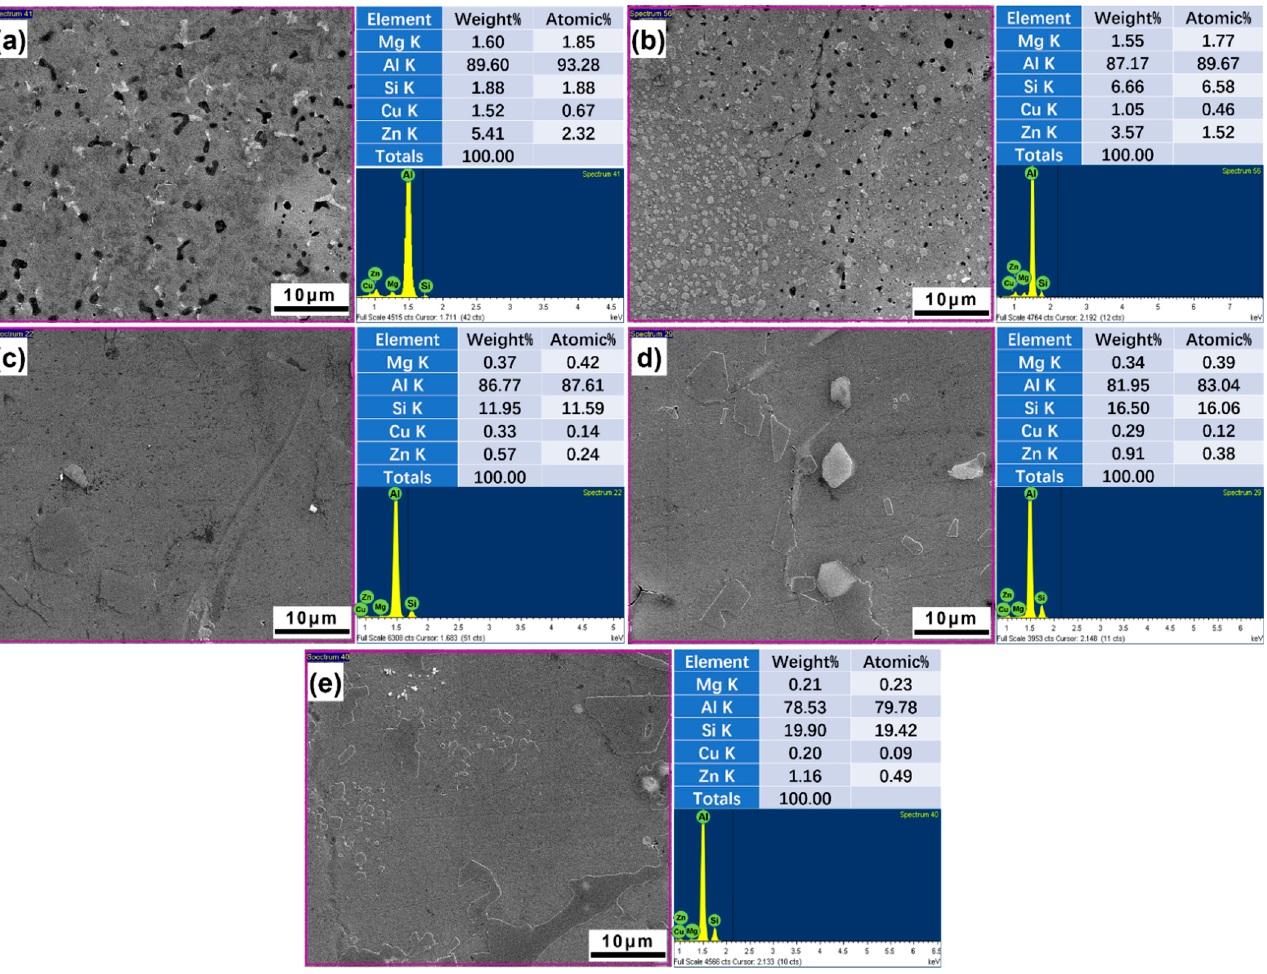
Figure 3. Microstructures and EDS results of the five layers selected from co-spray-formed Al-Si/7075 bimetallic gradient alloys: ( a ) first layer, ( b ) second layer, ( c ) third layer, ( d ) fourth layer and ( e ) fifth layer.